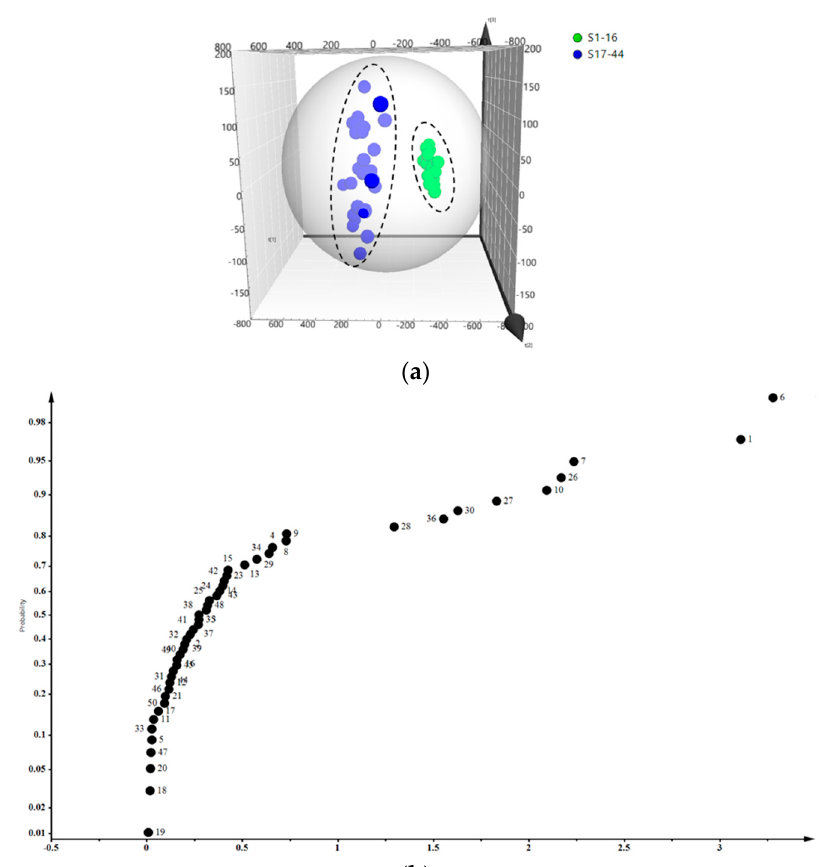
Figure 3. Score scatter plot ( a ) and VIP ( b ) by PLS-DA processed data obtained from LJF and LJC. Each of the blue circle represented a batch of LJF, the green circle represented a batch of LJC, each of the black circle represented a compound (see Table 1 for compound names).